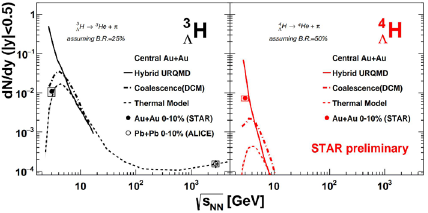
< 0.5 as a H (a) and 4 H (b) yields at y Figure 2. 3 Λ Λ | | function of beam energy in central heavy ion collisions. The symbols represent measurements while the lines represent di ff erent theoretical calculations. The data points assume a branching 3 He( 4 He) + π − . ratio of 25(50)% for 3 H( 4 H) Λ Λ →